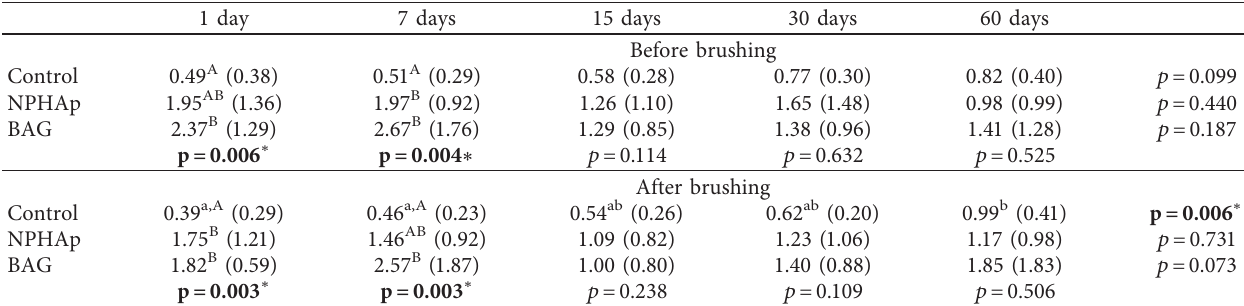
Table 3: Surface roughness (Ra) over time (days), before and after brushing test, for each experimental group-mean (standard deviation).